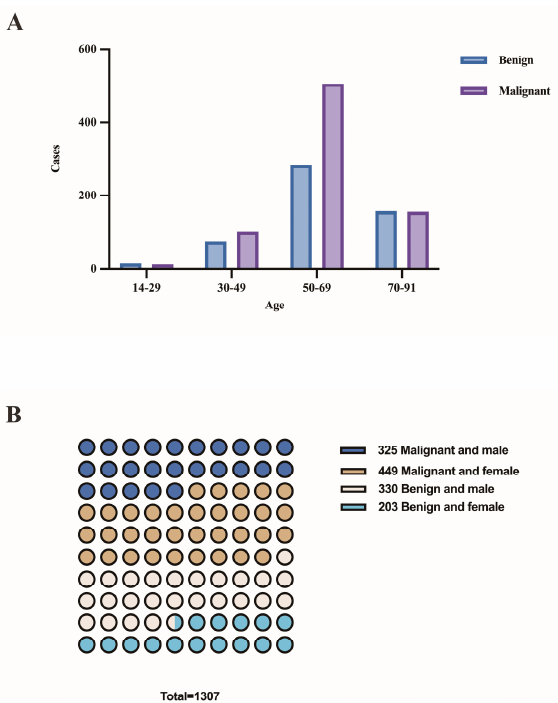
Figure 3. ( A ) The distribution of benign and malignant pleural effusions by age. ( B ) The distribution of benign and malignant pleural effusions by sex.